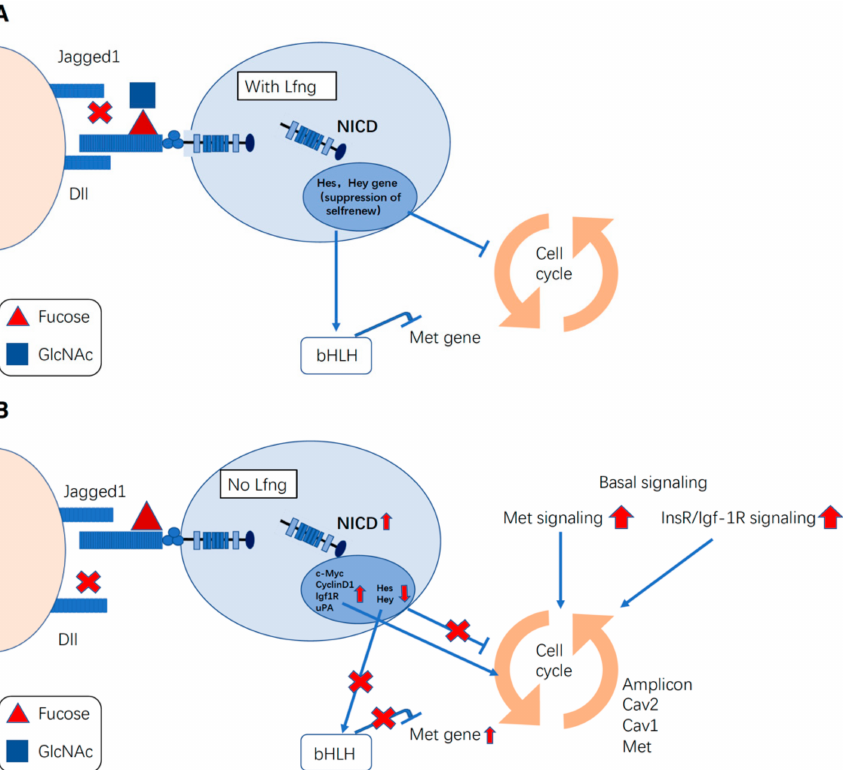
Figure 3. Significant involvement of lunatic Fng (LFNG) in triple-negative breast cancer (TNBC) [134]. ( A ) Activation of Notch signaling activation with Lfng. LFNG can enhance the binding between Notch receptor to DLL ligand in TNBC. ( B ) Activation of Notch signaling without Lfng in TNBC. LFNG deficiency can lead to increased JAG1-mediated Notch activation, and upregulated C-MYC, Cyclin D1, insulin-like growth factor 1 receptor (Igf-1R), and urokinase plasminogen activator (uPA) expression resulted in increasing proliferation. Meanwhile, Met/Caveolin Amplicon increased the abundance of Met and Caveolin 1/2, whose proteins can enhance signaling via IGF-1R and insulin-receptor substrate (IRS). Met and IGF-1R signaling can also stimulate